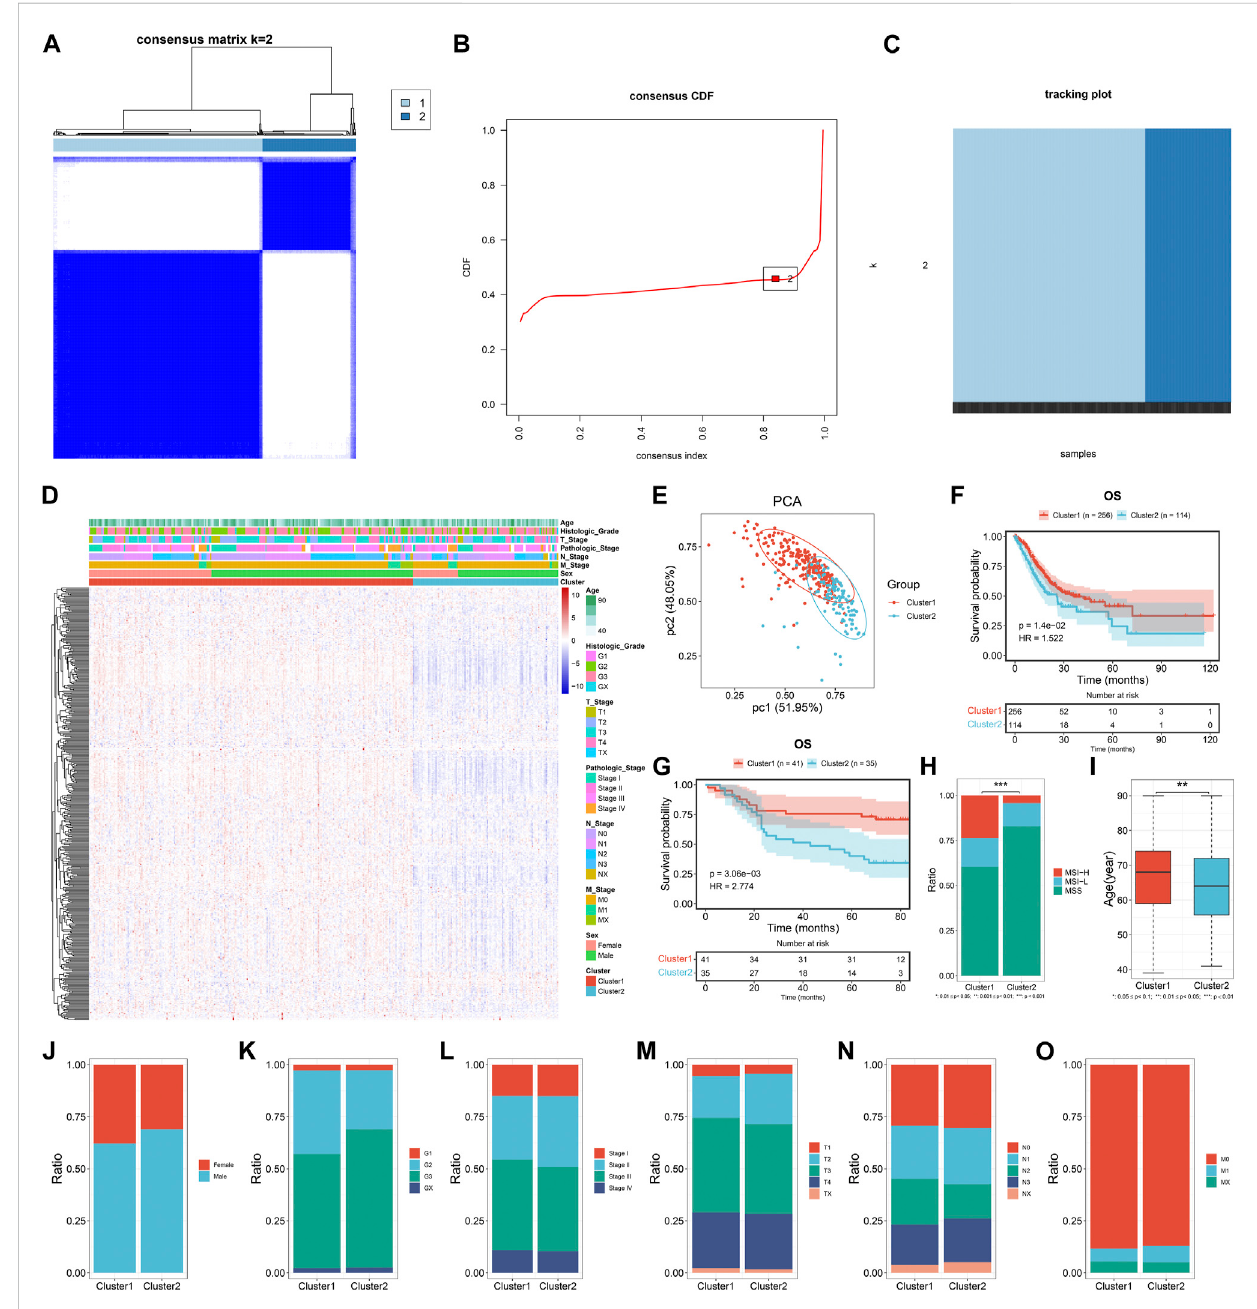
FIGURE 1 Construction and veri fi cation of a subtype classi fi cation of gastric cancer based on DNA damage repair genes. (A – C) Consensus matrix, CDF, and track plot across TCGA-STAD based upon the expression values of DNA damage repair genes. (D) Transcriptional levels of DNA damage repair genes in the two DNA damage repair-based subtypes. Colors from blue to red denote low to high expression levels. (E) PCA for proving the subtype classi fi cation according to the expression values of DNA damage repair genes. (F,G) K-M curves of OS between subtypes in the TCGA-STAD and GSE84426 cohorts. (H) Distribution of MSI-L, MSI-H and MSS subtypes across the two subtypes in the TCGA-STAD dataset. (I – O) Distribution of clinicopathological traits across the two subtypes in the TCGA-STAD